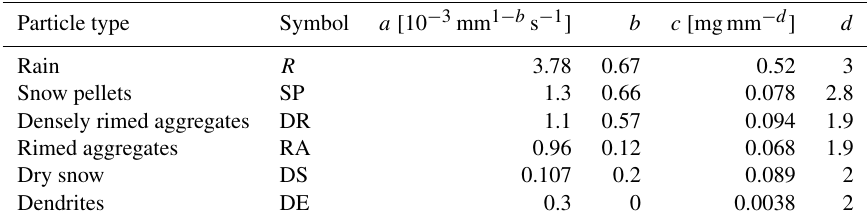
Table A1. Fall speed–diameter, v(D) = aD b in ms − 1 , and mass–diameter, m(D) = cD d in mg, used to diagnose the type of precipita- tion using the Ishizaka et al. (2013) method. The values are from Atlas and Ulbrich (1977), Locatelli and Hobbs (1974), Ishizaka (1995), Rasmussen et al. (1999) and Nakaya (1954), respectively. The diameter, D , is in